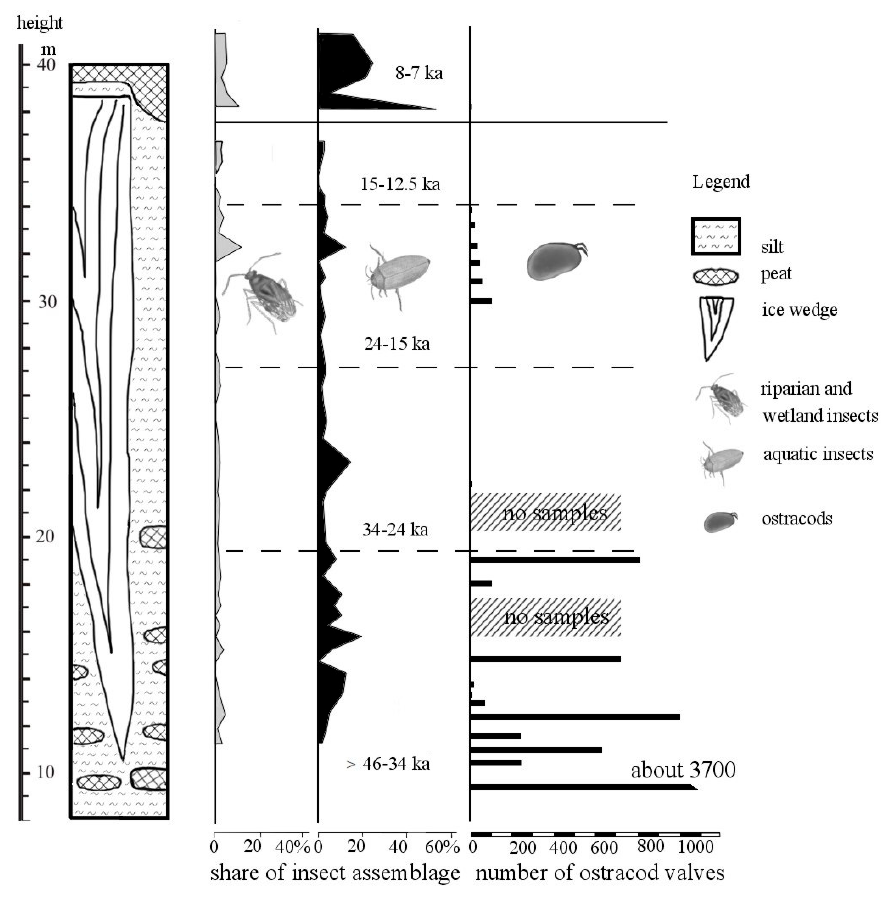
Figure 14. Distribution of aquatic and riparian insects in the section Mamontovy Khayata, Bykovsky Peninsula, Northern-East Siberia [13] compared with the ostracod record [37]. Ostracod bulk samples were taken throughout the section except some inaccessible loci. To obtain insect assemblages, large sediment samples (40–50 L) were wet sieved